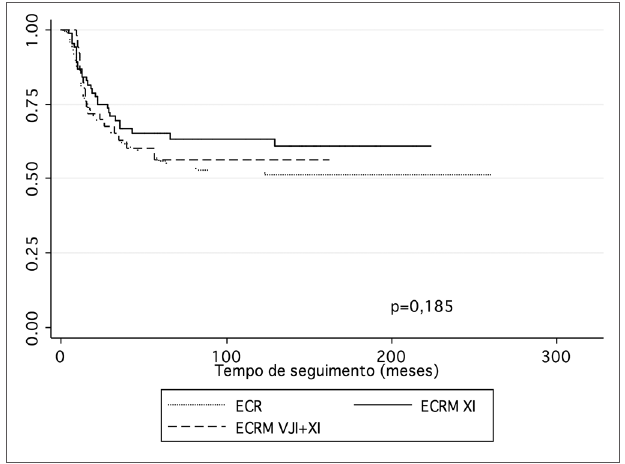
Figura 2. Sobrevida em função do tipo de esvaziamento cervical